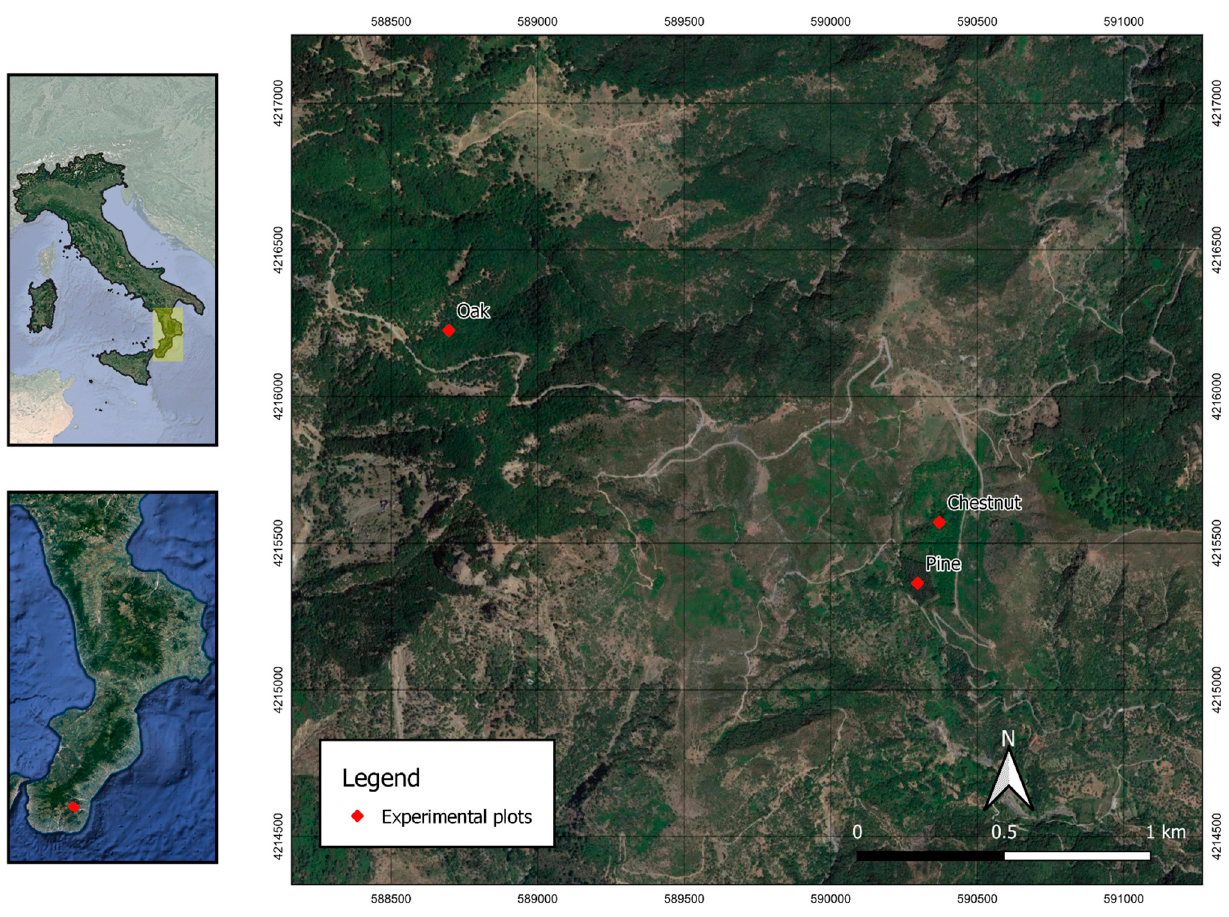
Figure 1. Location of the experimental sites (Samo, Calabria, Southern Italy).